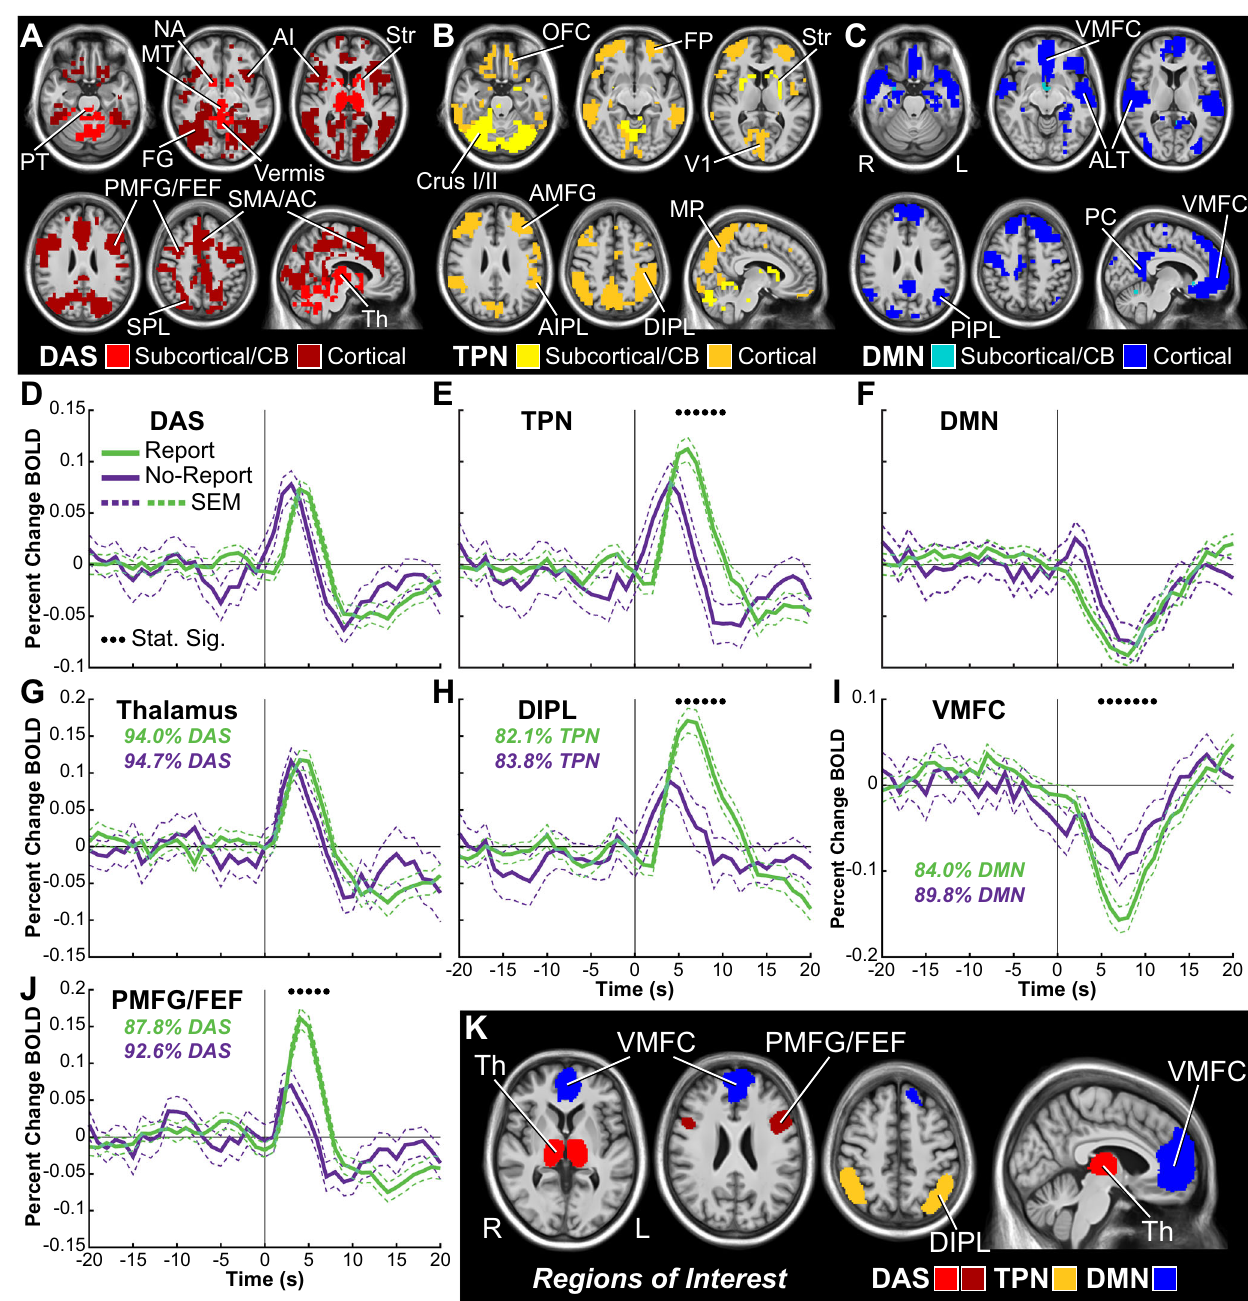
Fig. 6 | Data-driven anatomical clustering of fMRI signals for conscious per- ception and region of interest (ROI) timecourses. A – C Three large-scale net- works found with k-means clustering based on fMRI timecourses (Fig. S20). A Detection, arousal,and saliencenetworks (DAS), B task-positive networks (TPN), and C default mode network (DMN). Cortical and subcortical/cerebellarterritories are shown in different shades. D – F Mean percent change blood-oxygen-level- dependent (BOLD) timecourses for report (green) and no-report (purple) per- ceived minus not perceived conditions for DAS, TPN, and DMN. G – J Selected subregion mean percent change BOLD timecourses (see also Figs. S21 – 23). Per- centagesofvoxelsfromaparticularnetwork(DAS,TPN,orDMN)versusallnetwork voxelsfound in each ROIare shown for report (green) and no-report(purple) data (Full details on methods and materials are available in the Supplementary Infor- mation). K Anatomical visualization of subregion ROIs from G , H , I , and J . Pontine tegmentum (PT), midbrain tegmentum (MT), thalamus (Th), nucleus accumbens